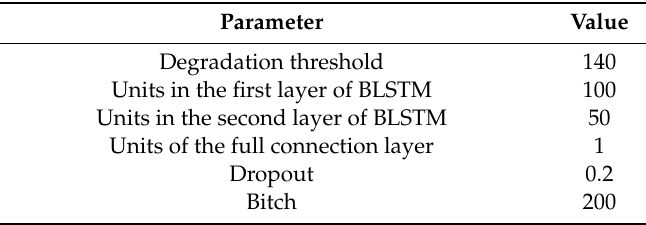
Table 4. Parameter setting of the LSTM hybrid model.